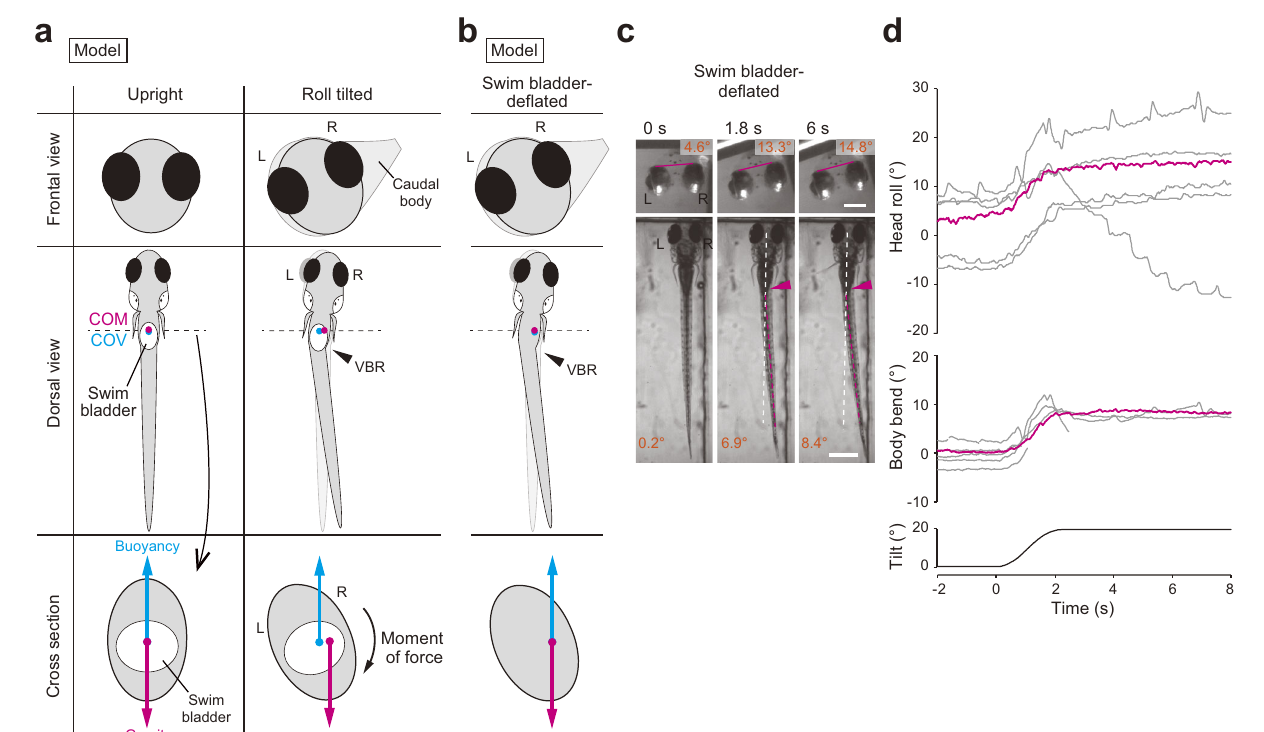
Fig. 2 | Biomechanics for the VBR-mediated postural recovery. a A model of postural recovery from roll tilt by the VBR. Frontal and dorsal views and cross- section around the swim bladder. Gravity and buoyancy act at the center of mass (COM) and center of volume (COV), respectively. The COM and COV are located nearthe swimbladder,andthe COMislocated slightlyrostraltothe COV 24 . Inthe dorso-ventral axis, the model assumes that the COM and COV are located in the same position. Left: the COM and COV are on the midline. Right: in the fi sh performing the VBR upon a roll tilt, the head and caudal body move toward the ear-up side, while the body around the swim bladder moves toward the ear-down side(topandmiddle).TheCOMandCOVmovetowardtheear-updirectioninthe cross-section (bottom). The COM moves more laterally than the COV (see main